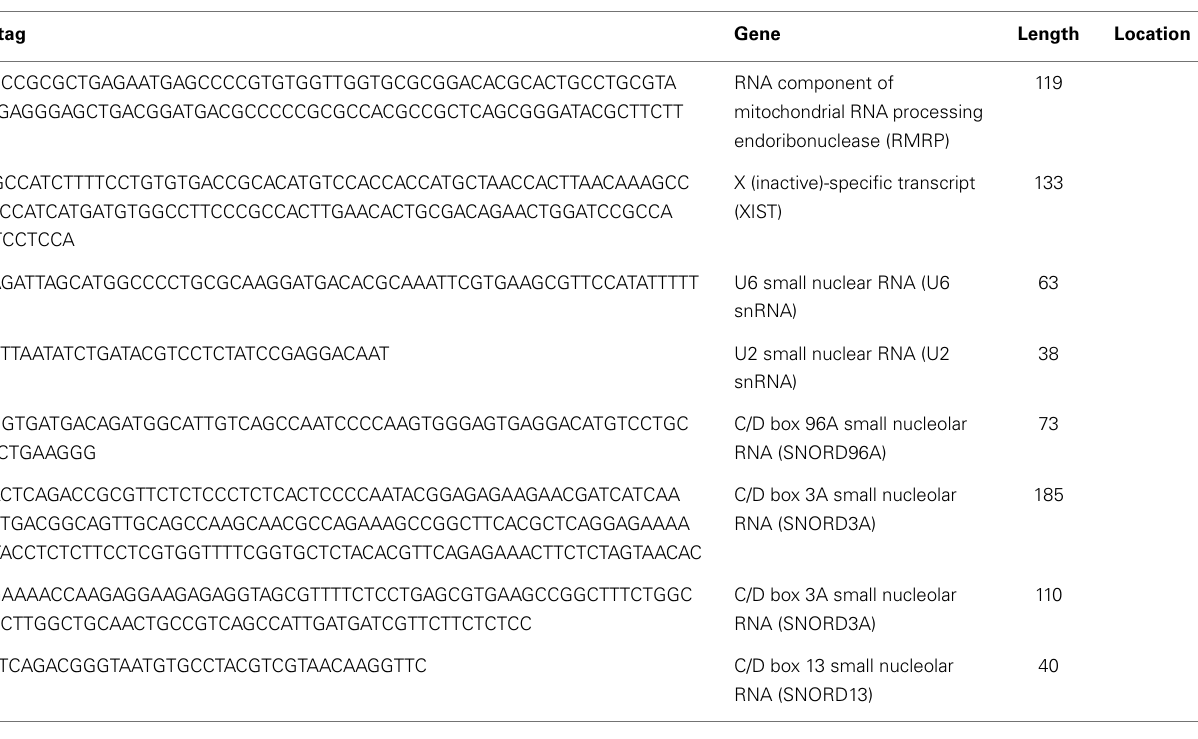
TableA2 |Annotated list of IRS-1 CLIP tags (non-coding